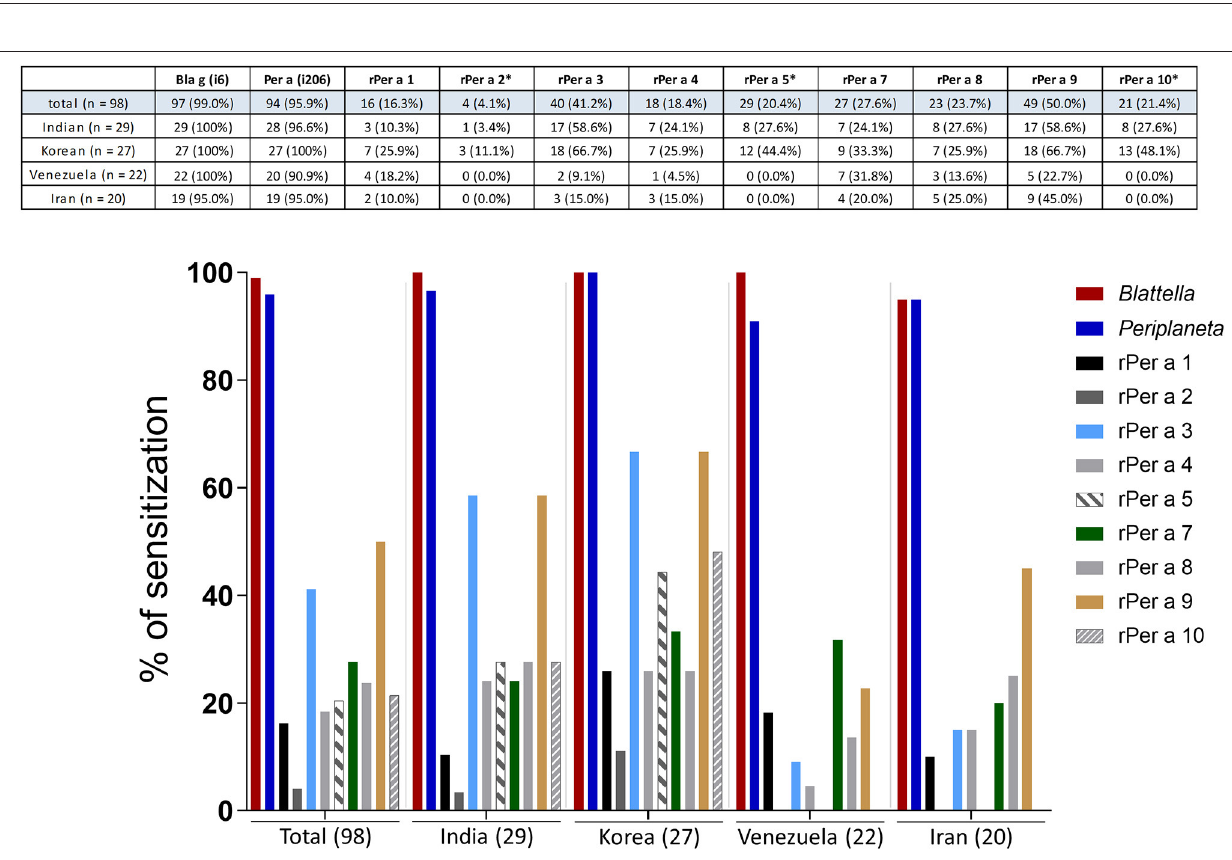
Frontiers in Allergy |